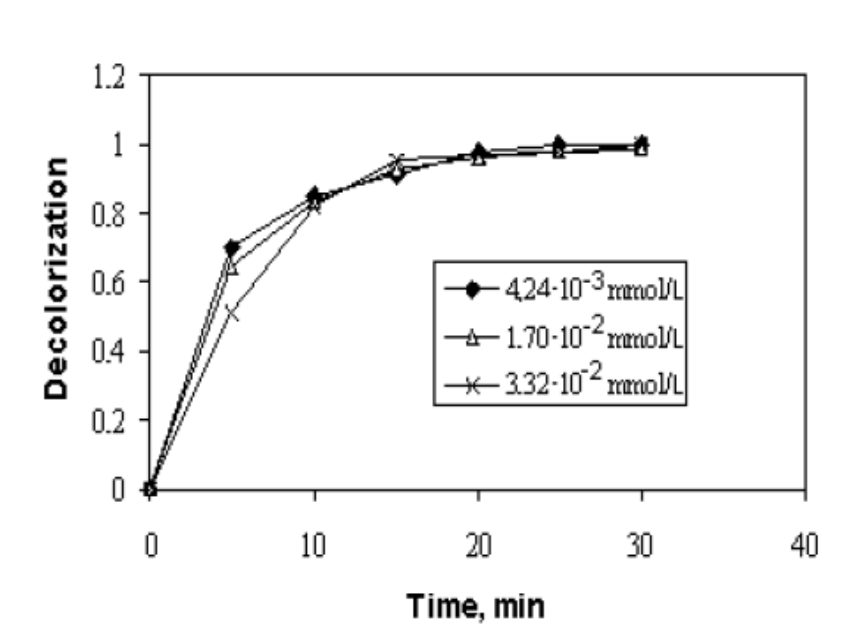
Fig. 7 Effect of Co 2+ ions on AOP in acidic medium. Initial conditions: C dye =50 mg/L, [H 2 O 2 ]= 17.318 mM.